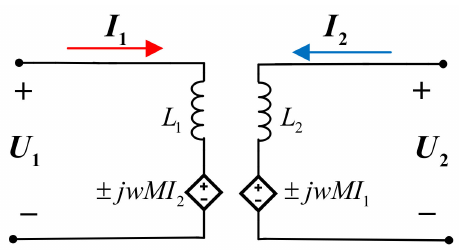
Figure 4. Mutual inductance equivalent model of loosely coupled transformer (LCT).